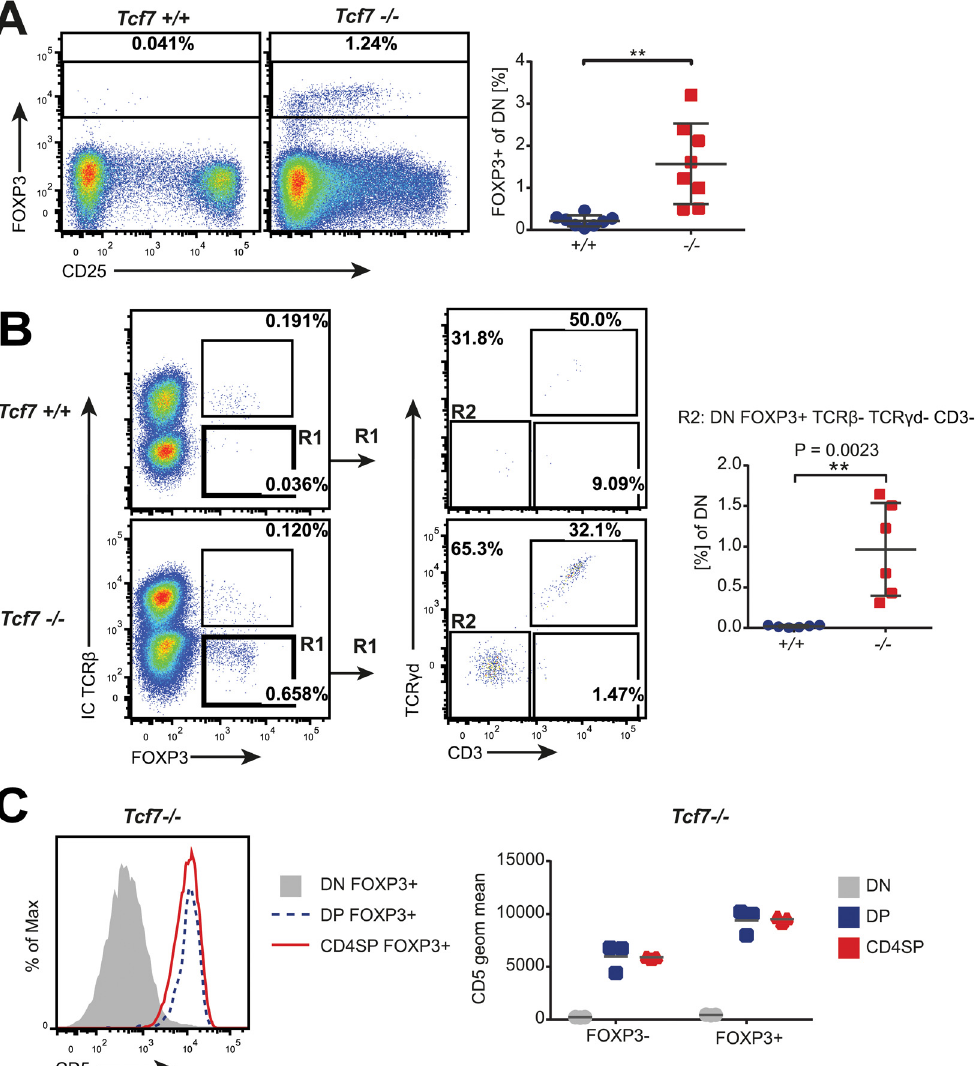
Fig 1. Foxp3 expression at the DN cell stage in Tcf7-deficient mice. (A) Representative plots and quantification of Foxp3 staining in CD4 - CD8 - (DN) thymocytes from Tcf7 +/+ and Tcf7 -/- mice (n = 8). (B) Left panels: Representative plots showing Foxp3 and intracellular (IC) TCR β staining in DN thymocytes from Tcf7 +/+ and Tcf7 -/- mice. Middle panels: TCR γδ and CD3 staining on DN Foxp3 + TCR β - cells (gate R1). Right panel: Quantification of DN Foxp3 + TCR β - TCR γδ - CD3 - cells (gate R2) depicted as the percentage of total DN cells (n = 6). (C) Left panel: Representative histograms showing CD5 staining on Foxp3 + DN, Foxp3 + DP, and Foxp3 + CD4SP cells from Tcf7 -/- mice. Right panel: Quantification of CD5 geometric mean from DN, DP, and CD4SP Foxp3 + or Foxp3 - populations (n = 3). Mean + SD are shown for all quantified data. Numbers show percentages of cells within the indicated box. Each symbol represents an individual animal. ** P < 0.01 (unpaired